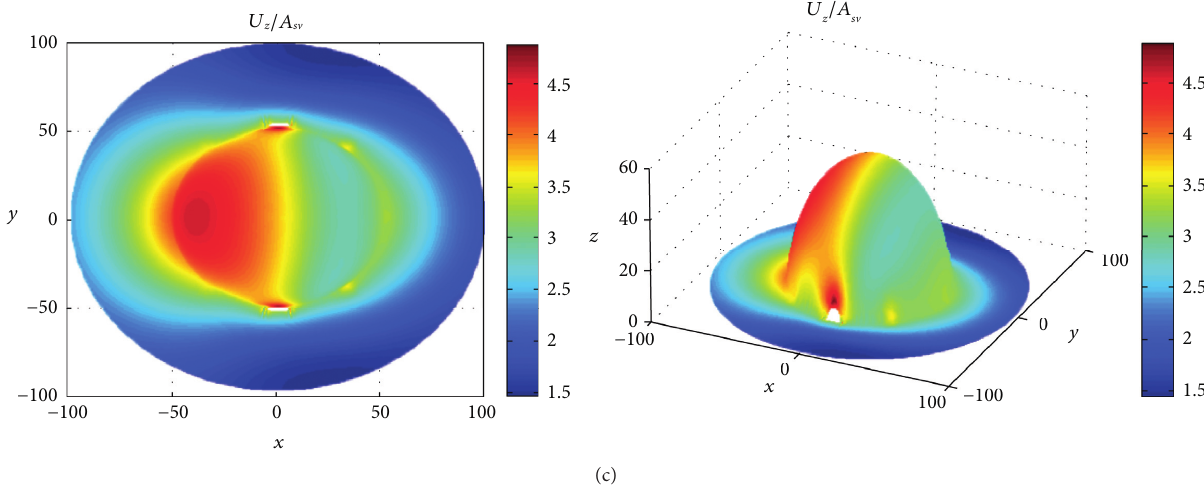
Figure 15: Surface displacement amplitude of the 3D tunnel mountain under the incident SV wave ( η � 0 . 5 , α � 30 ° ): (a) surface dis- placement amplitude in x direction; (b) surface displacement amplitude in y direction; (c) surface displacement amplitude in z